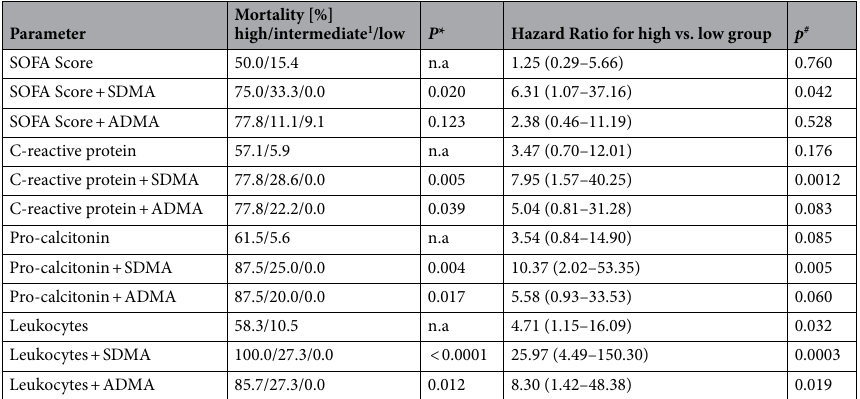
Table 2. Predictive power of the SOFA score, C-reactive protein levels, and pro-calcitonin levels at admission for in-hospital mortality, when analysed alone or in combination with SDMA or ADMA. 1 Mortality of the subgroups is given for the dichotomized SOFA score, C-reactive protein, and pro-calcitonin values when analyzed alone (no intermediate risk group), as well as for the highest risk group (traditional risk marker high plus SDMA/ADMA high), the intermediate risk group (traditional risk marker or SDMA/ADMA high), and lowest risk group (traditional risk marker plus SDMA/ADMA low). * P denotes statistical significance level in logrank test for trend across all risk groups. # p denotes statistical significance level for the hazard ratio of the high vs. low-risk groups. SOFA, sequential organ failure assessment; SDMA, symmetric dimethylarginine; ADMA, asymmetric